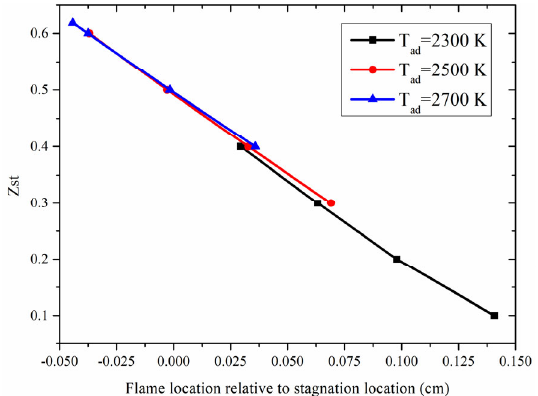
Figure 5. The variation of the relative position of the flame sheet and the stagnation plane in the calculated 3 × 4 conditions.